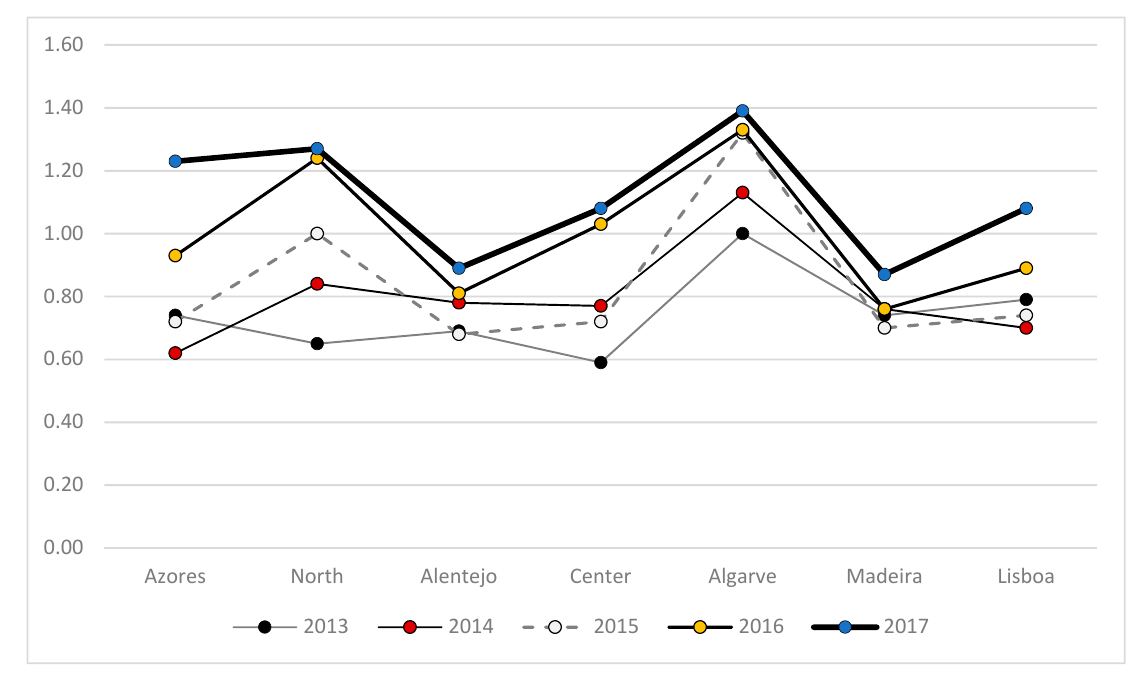
Figure 3. Current Ratio, by NUT II regions.